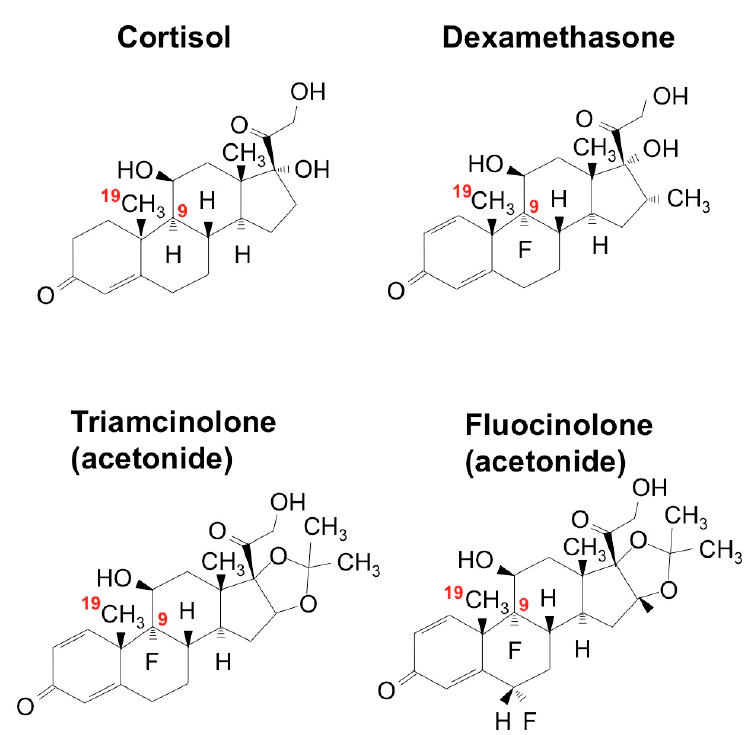
Figure 6. Chemical structures of glucocorticoids. The positions of C9 and C19 are indicated in red. FA dramatically enhanced the chondrogenesis from mesenchymal stem cells in vitro when it was combined with transforming growth factor (TGF)- β 3. Furthermore, analysis in vivo revealed the ability of FA to regenerate damaged articular cartilage in collaboration with TGF- β 3 [55]. TGF- β 3, as a member of the TGF- β superfamily, is known to enhance extracellular matrix deposition mainly through the canonical signaling pathway mediated by secondary messengers termed Smads. The observed effect of FA was shown to be mediated by the mammalian target of the rapamycin (mTOR)-AKT signaling pathway as well as by the interaction with the Smad pathway and GR activation. This collaboration is highly member-specific, since FA combined with BMP-2, another member of TGF- β superfamily, did not show such an effect. Similarly, articular cartilage regeneration in vivo was not effectively exerted by the combination of TGF- β 3 and either TA or Dex. A structural comparison between these three compounds suggests a structural–functional relationship between corticosteroids and the extra functionality to regenerate cartilage in collaboration with TGF- β 3 (Figure 7a) [55]. Obviously, the fluoride modification at C16 adds a structural property to enable the unusual collaboration of FA with TGF- β . It should also be noted that FA is able to strongly induce CCN2 expression in ATDC5 chondrogenic cells, which may result in the modification of TGF- β signaling via direct molecular interaction between these molecules (Figure 7b). Since CCN2 itself regenerates articular cartilage, involvement of this protein in the outcome of FA-TGF- β 3 collaboration is strongly suspected (Figure 8). In the field of orofacial medicine, TMJ dysfunction based on osteoarthritis is one of the major complications that affects proper mastication. However, there are currently no therapeutics for regenerating damaged TMJ cartilage that has been established. However, FA has already been widely approved and is being used in clinics, meaning that its clinical application for recovering damaged TMJ cartilage is now expected, although particular care should be taken to avoid possible side effects as a